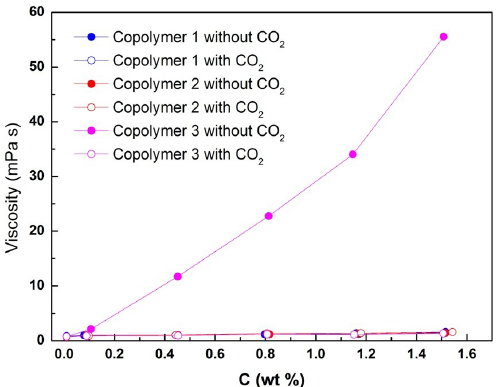
Figure 7. Viscosity of aqueous solutions containing copolymers 1, 2, and 3 in the presence of air and CO 2 at 25 ± 0.5 °C.